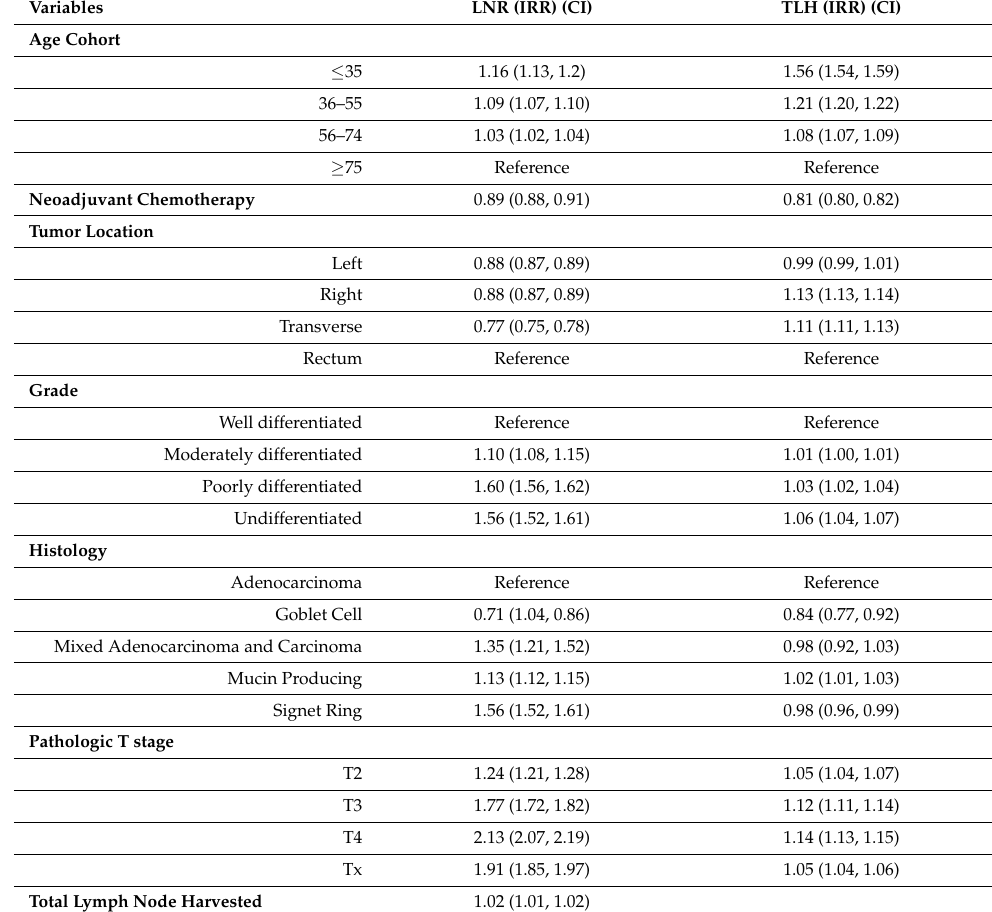
95% CI; TLH—Total Lymph Node Harvested, LNR—Lymph Node Ratio, IRR—Incident Rate Ratio, CI—Confidence